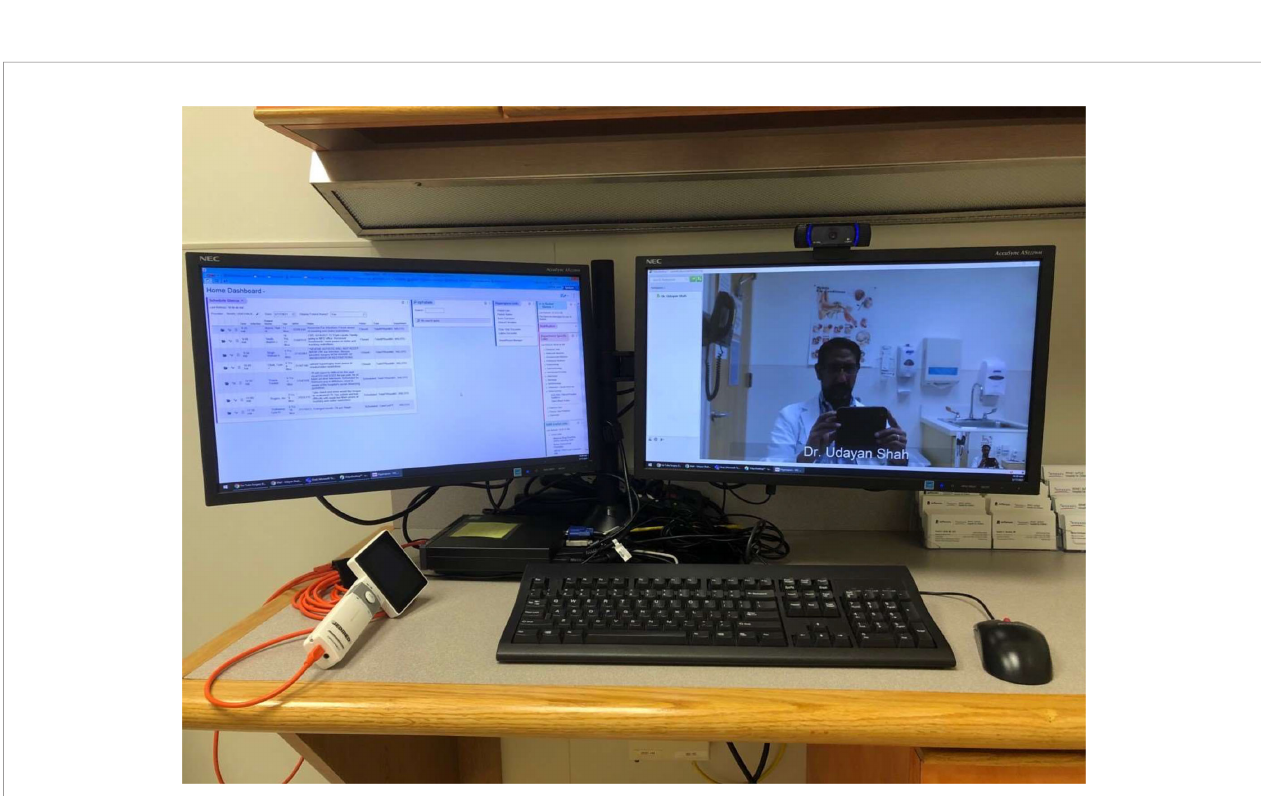
FIGURE 2 | Possible telemedicine setup. A two-screen setup allows the medical record to be seen on the left, while the examination can be seen on the right. A white hand-held video-otoscope is seen to the left of the keyboard (Image courtesy of Dr. Udayan Shah).